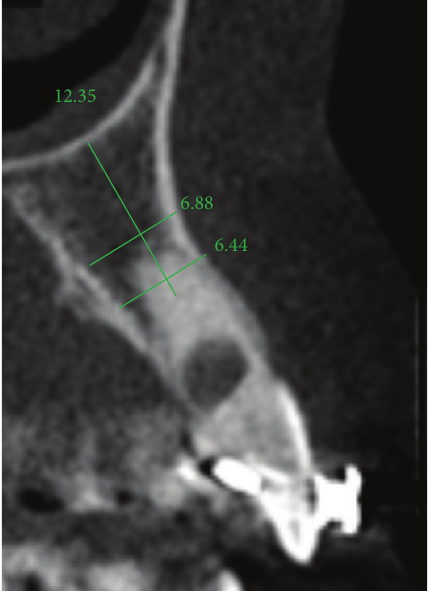
Figure 3: Initial computed